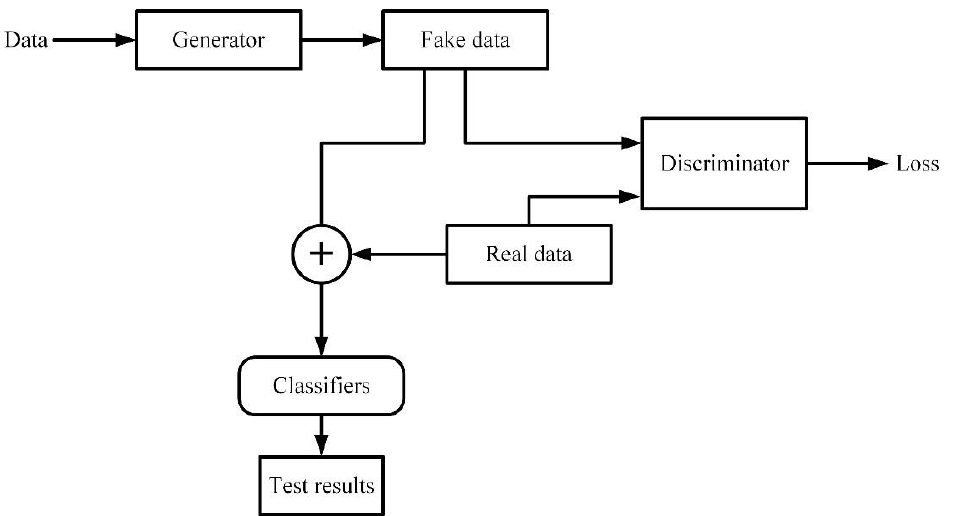
Figure 22. The MRI brain tumor segmentation based on GAN. At the end of 2016, the semantic segmentation model based on adversarial networks is proposed. The method treats the segmentation network as a generator to train the network [156]. Li et al. tried to use GAN for MRI brain image segmentation at the MICCAI conference [157]. They trained the generator network and the discriminator network to- gether to reduce the difference between the synthetic label and the real label. Furthermore, the high-order loss terms are used to enhance the spatial continuity of the segmentation results. Rezaei et al. proposed a new end-to-end training conditional generation confrontation network CGAN based on the GAN network [158]. The segmentation network and the discriminator network are changed to U-Net and Markovian GAN, respectively. The two networks are simultaneously trained through backpropagation to improve the seg- mentation accuracy. In 2019, Rezaei et al. proposed a new confrontation network called voxel-GAN [159]. It is mainly used to alleviate the problem of data imbalance in the brain tumors segmentation, since the proportion of tumors or unhealthy areas is small. In addi- tion, there are methods that also introduce a 3D conditional generation confrontation net- work to alleviate the problem of brain tumor data imbalance based on the weighted ad- versarial loss generated by network training. Table 6. Evaluation results of MRI brain tumor segmentation based on GAN network. Reference